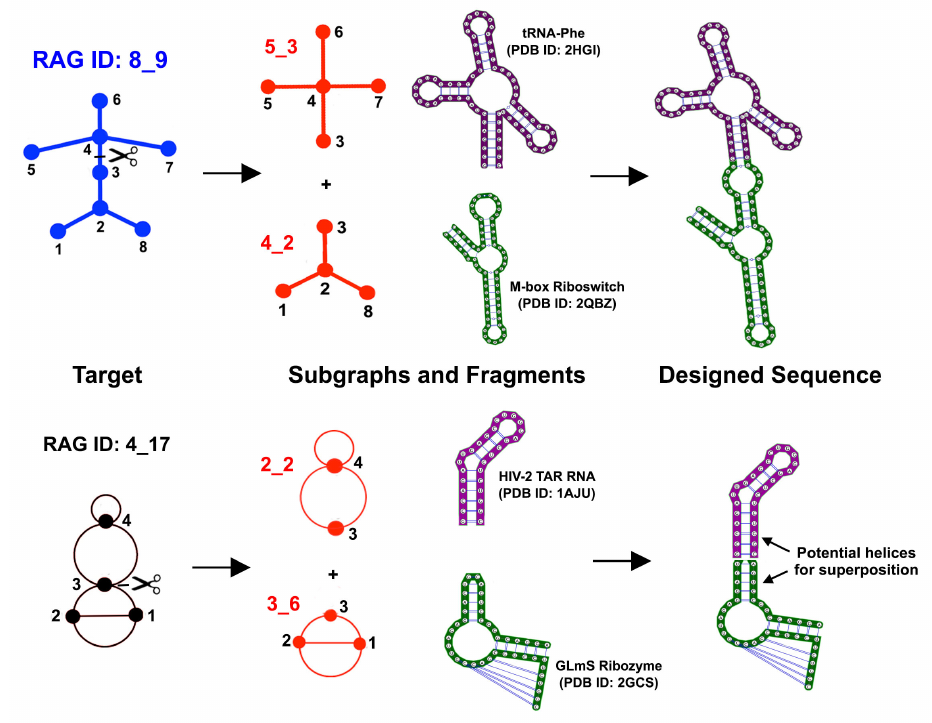
Figure 10. Proposed design pipeline for dual graphs. Fragment assembly for design of novel RNA topologies for tree and dual graphs using the RNA-As-Graph (RAG) subgraph and atomic fragment libraries. The tree graph design results are taken from [35], and a similar pipeline is proposed for dual graphs.